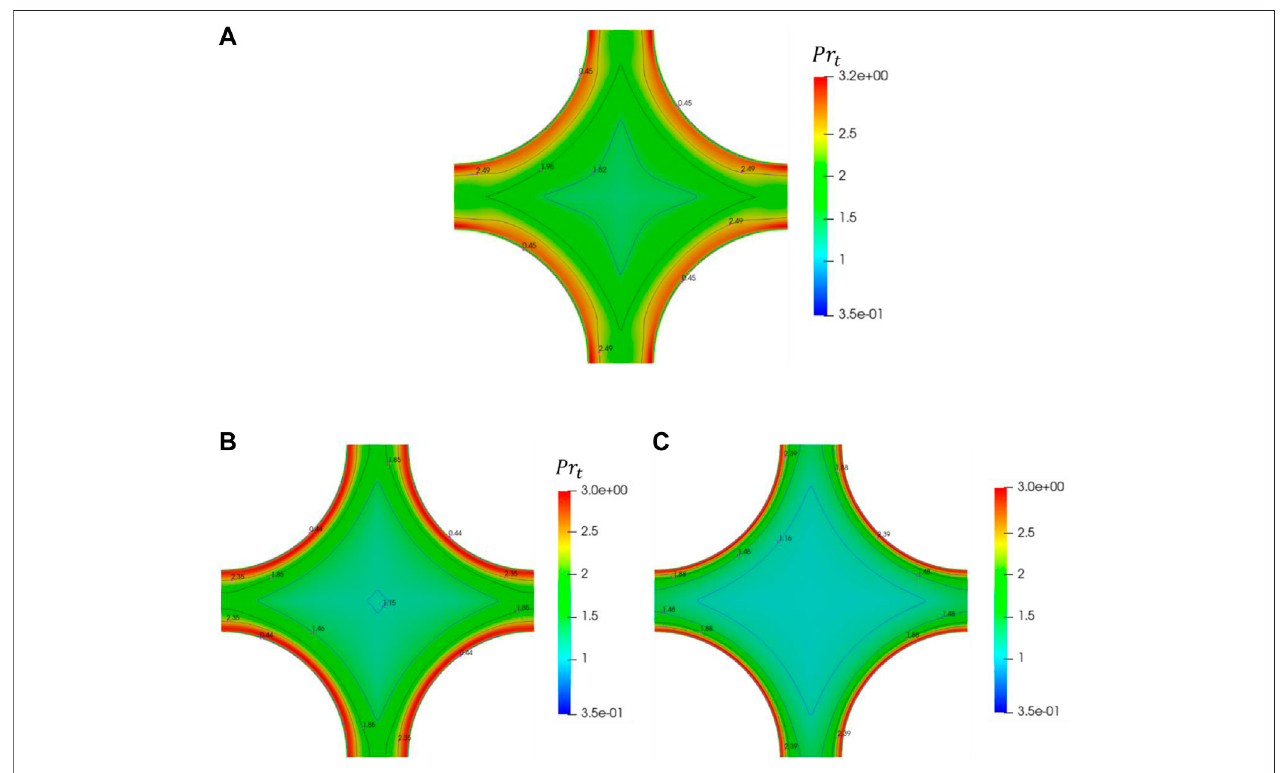
FIGURE 15 | Schematic diagram of turbulent Prandtl number on a slice for square lattice X = 1.25. (A) Pe = 1000; (B) Pe = 2000; (C) Pe = 4000.